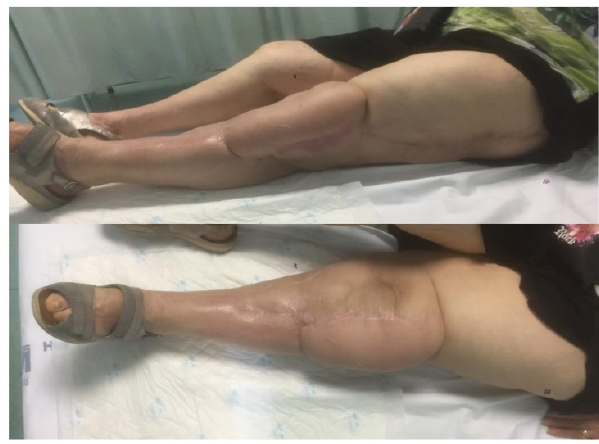
Figure 2 . Patient’s limb during the